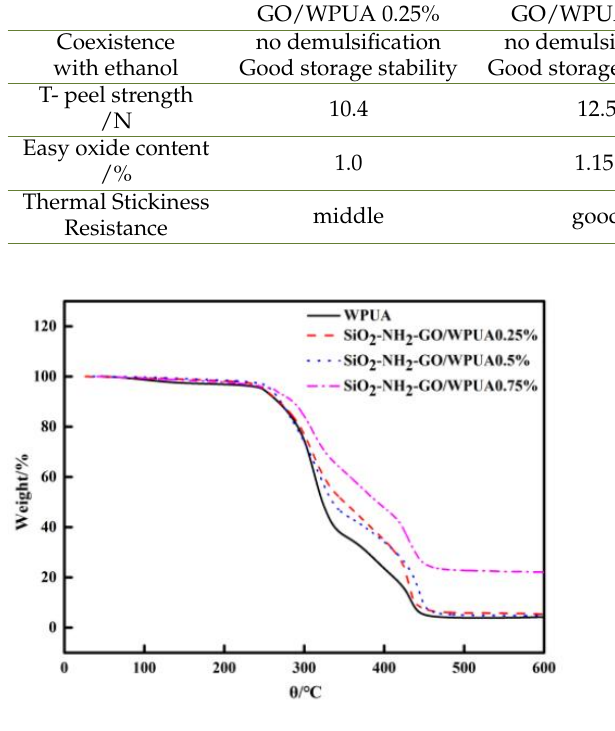
Fig. 5. thermogravimetric curves of WPUA and SiO 2 -NH 2 -GO/WPUA